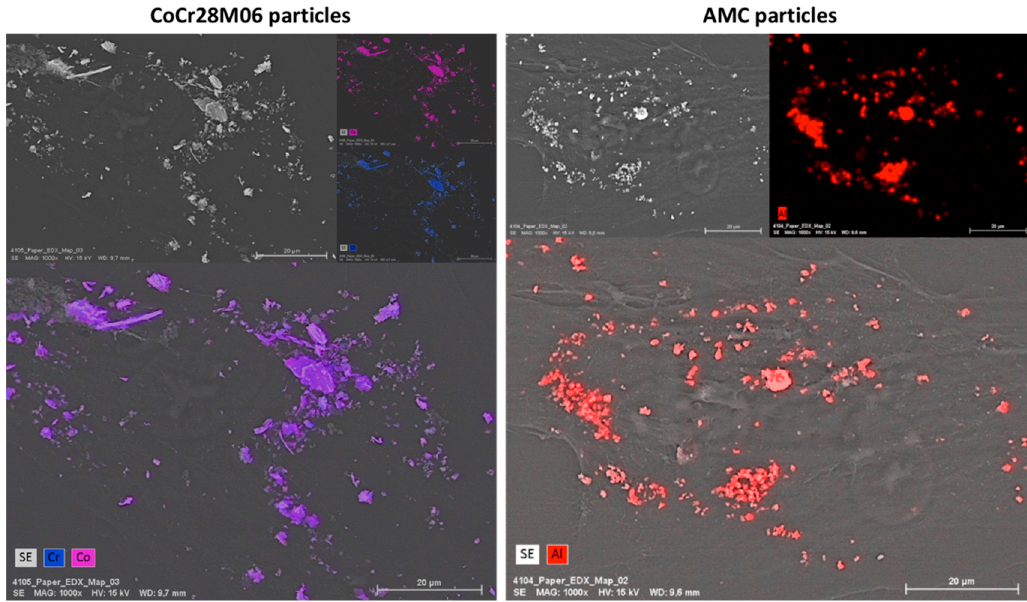
Figure 5. Representative FESEM pictures of human primary fibroblasts exposed to CoCr28Mo6 ( left panel ) and AMC ( right panel ) particles (scale bar: 20 µm). EDX measurements were carried out to identify the elements cobalt and chromium as well as aluminum.